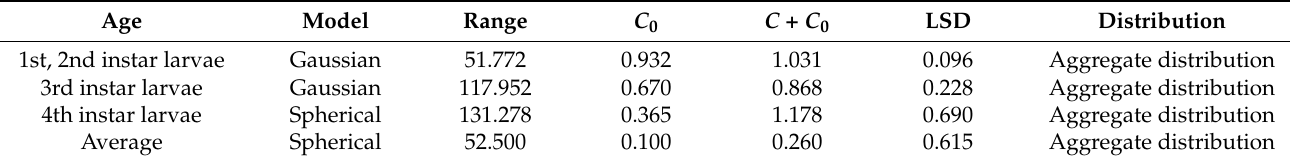
Table 3. Model parameters and spatial patterns of C. aeruginosa